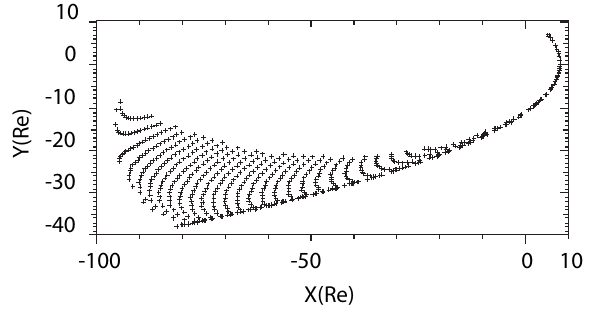
Fig. 8. Points of intersection of the northern polar cap open field lines with the equatorial plane, shown by crosses.